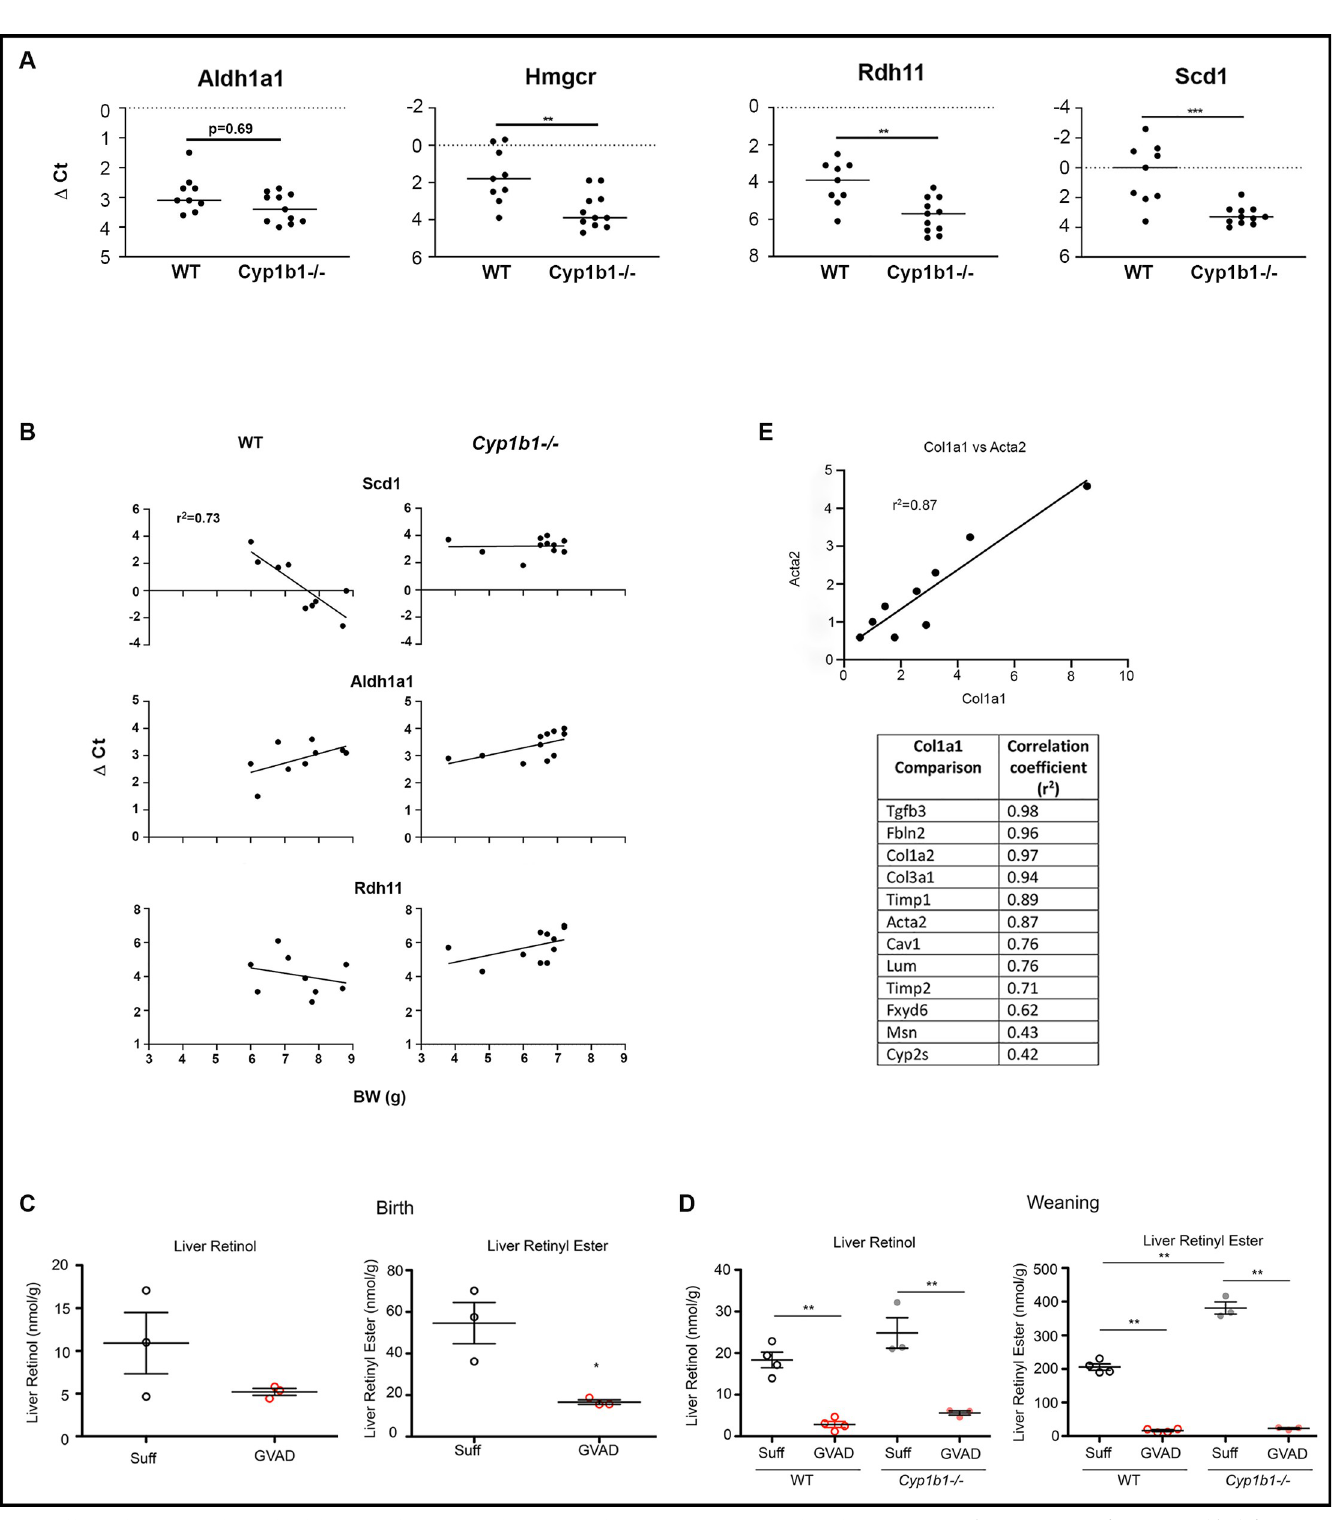
Fig 2. Effects of GVAD and Cyp1b1 deletion on liver retinoid content and gene expression at birth and weaning. PCR determinations of expression (dCt) for individual WT and Cyp1b1-/- mice from multiple litters at PN21: Aldh1a1 , Rdh11 , Scd1 , and Hmgcr (A). Correlations for expression versus body weight for WT and Cyp1b1-/- mice (B). Liver retinol and retinyl ester content at birth in WT (open circles) and Cyp1b1-/- (solid circles) vitamin A-sufficient (Suff; black) and GVAD (red) mice were measured on the pooled livers from separate litters (C). Equivalent measurements on livers from individual WT and Cyp1b1-/- at weaning/PN21 pups (D).